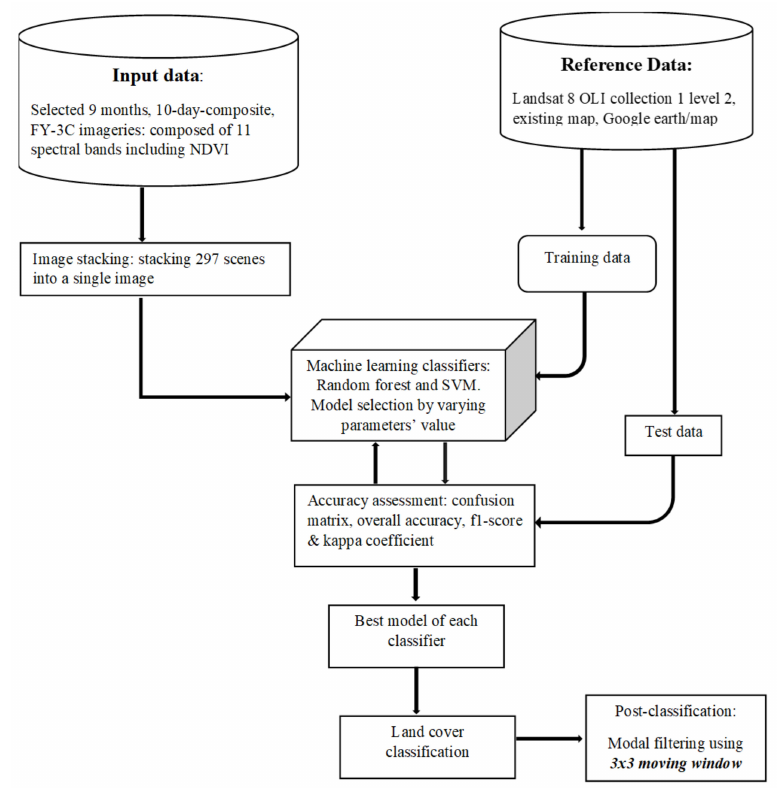
Figure 2. Technical route.